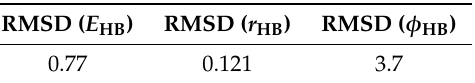
Table A3. Root-mean-square deviations (RMSD) for hydrogen bond binding energies ( E HB in kcal / mol), distances ( r HB in Å), and angles ( φ HB in degrees) between the pure B3LYP reference and the B3LYP / TIP3P